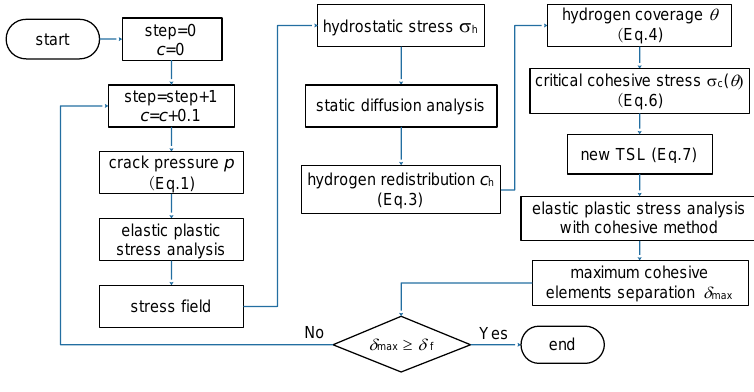
Figure 4. Simulation flow chat.